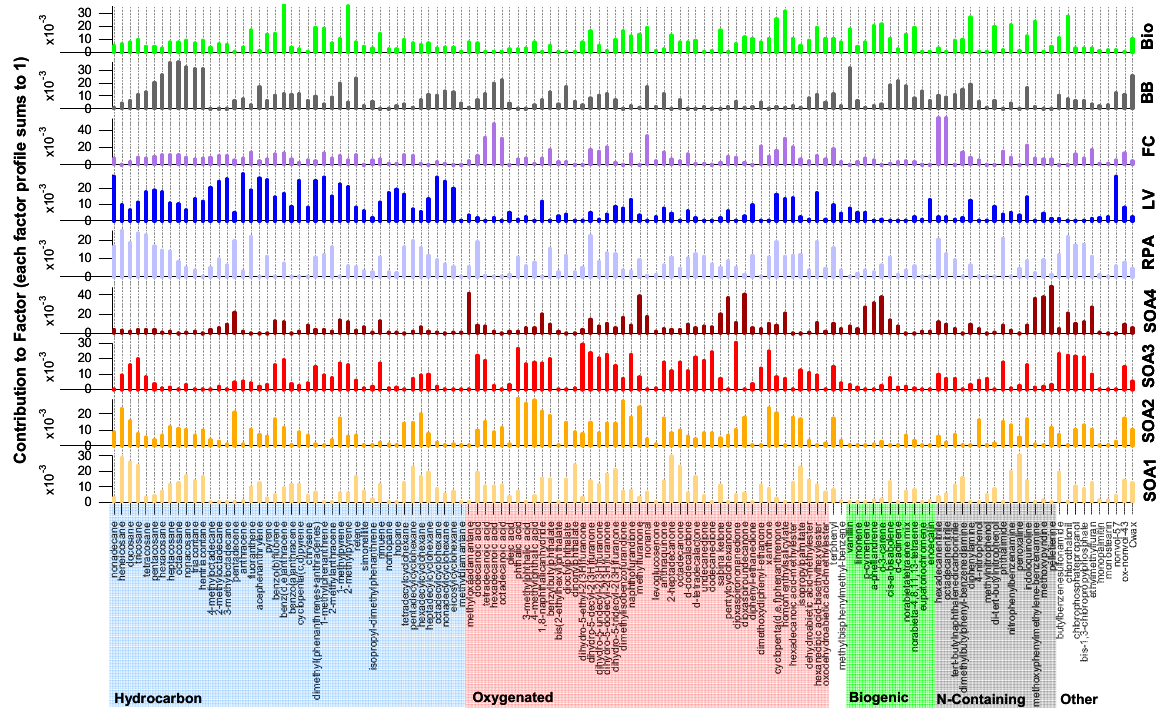
Fig. 6. Summer PMF profiles. Compounds are generally grouped by hydrocarbons (compound names with blue background), oxygenated species (red background), biogenics (green background), nitrogen-containing compounds (grey background), and others (white background), respectively. Total compound contributions to each of the 9 factor profiles sums to a value of 1.